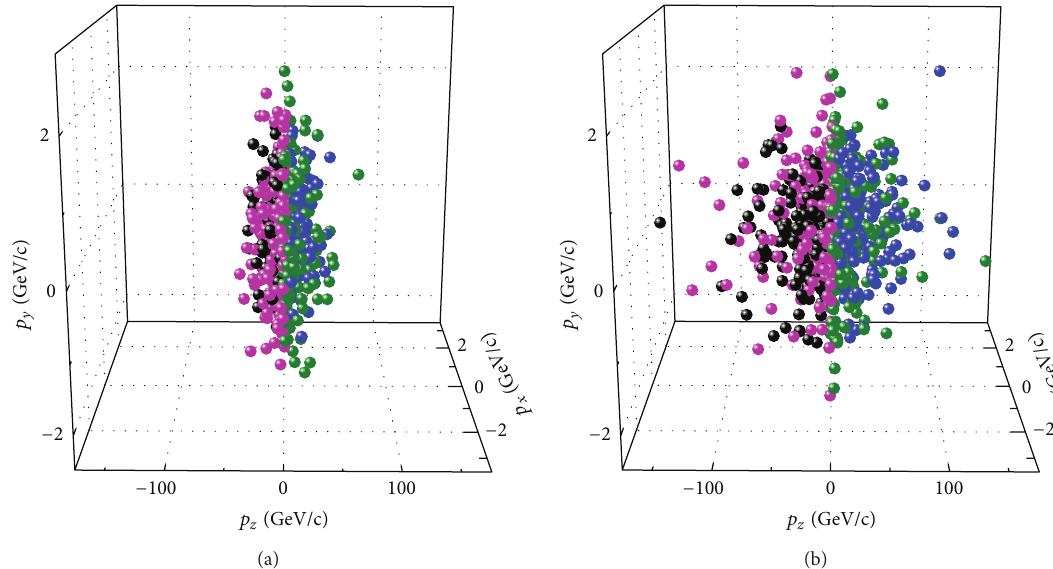
Figure 4: Same as Figure 3, but showing the scatter plots in 3D momentum space.